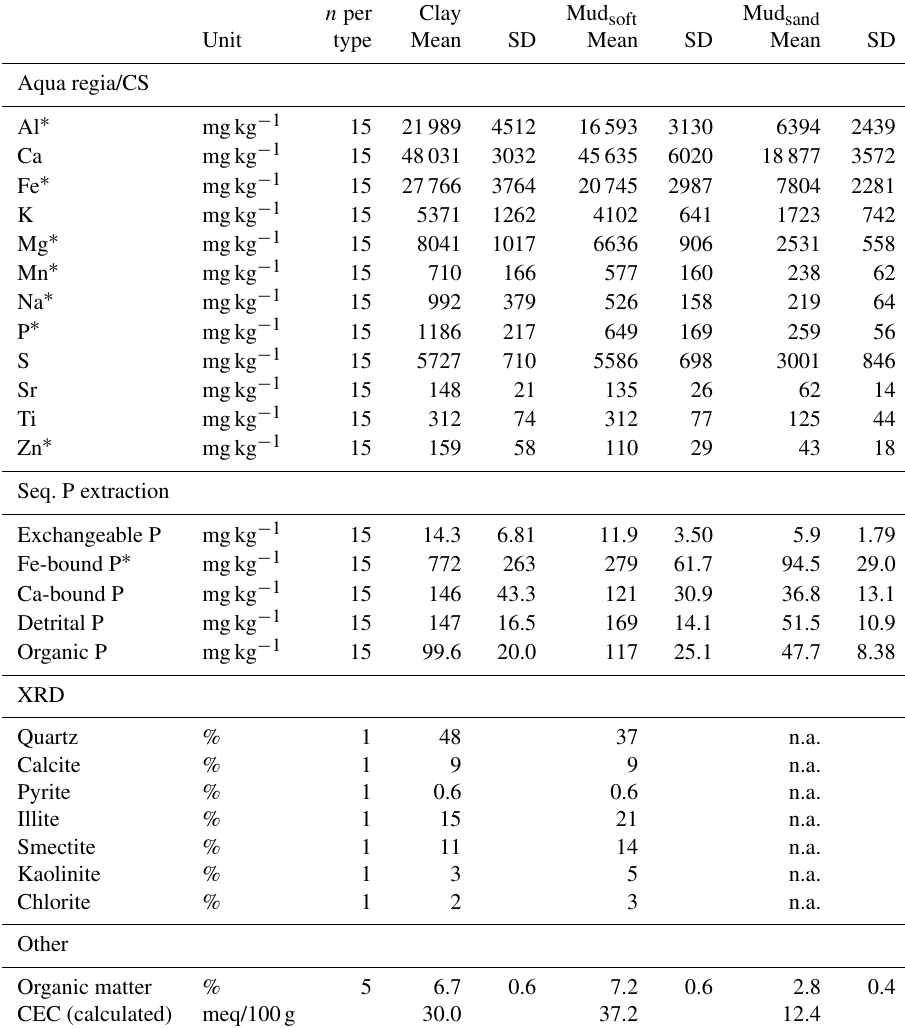
Table 2. Geochemical and mineralogical composition of the sediment types used in this study. Significant differences between Mud soft and Clay are indicated by ∗ ( p< 0 .